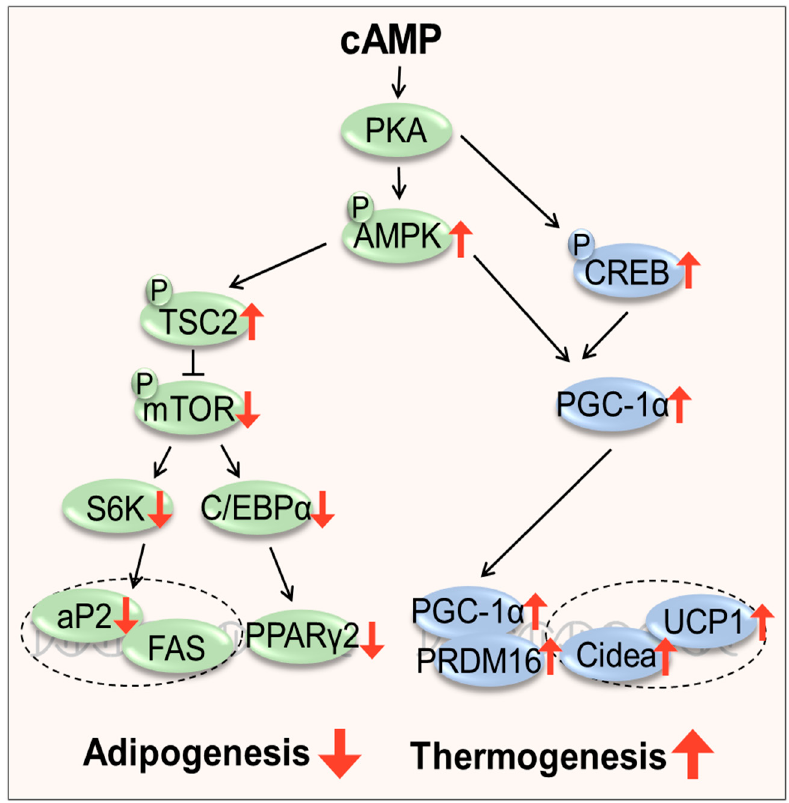
Figure 5. The proposed mechanism behind the protective effects of filbertone against adiposity in mice. High cytosolic levels of cAMP induced by filbertone activate PKA and thus cause phosphorylation of AMPK and CREB. Filbertone-induced AMPK activation inhibits adipocyte differentiation and blocks the expression of late adipogenic markers such as fatty acid synthase (FAS) and transcription factors, PPAR- γ 2 and C/EBP α , thereby inhibiting adipogenesis. Filbertone-induced CREB activation promotes the transcription of genes involved in thermogenesis, e.g., PGC-1 α and UCP1 , resulting in increased thermogenesis in adipocytes.